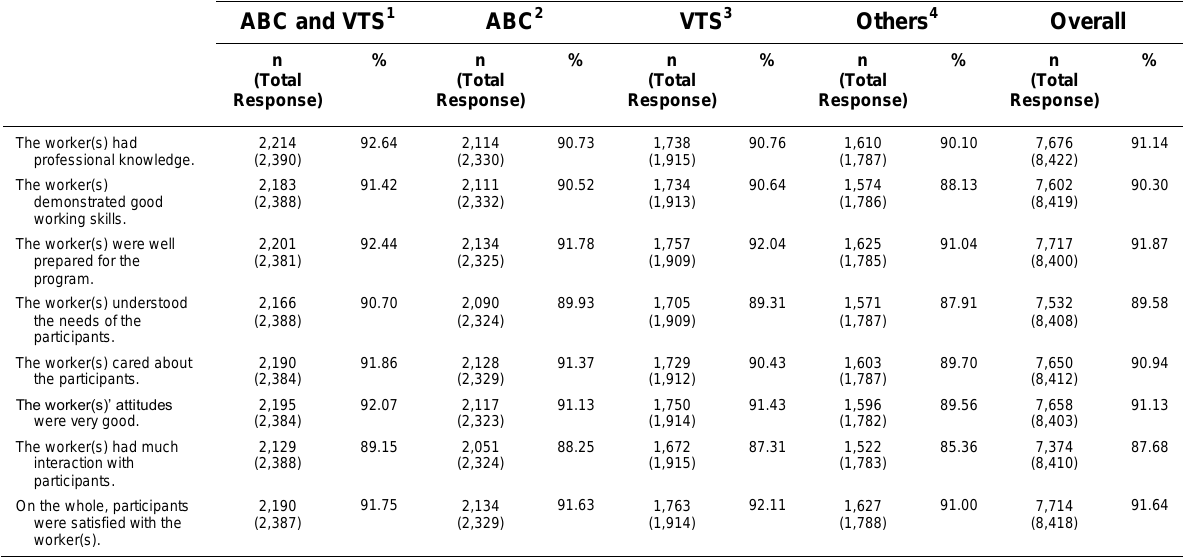
Comparison of the Positive Views towards the Tier 2 Program Workers among Different Program Approaches Participants with Positive Responses in Different Program